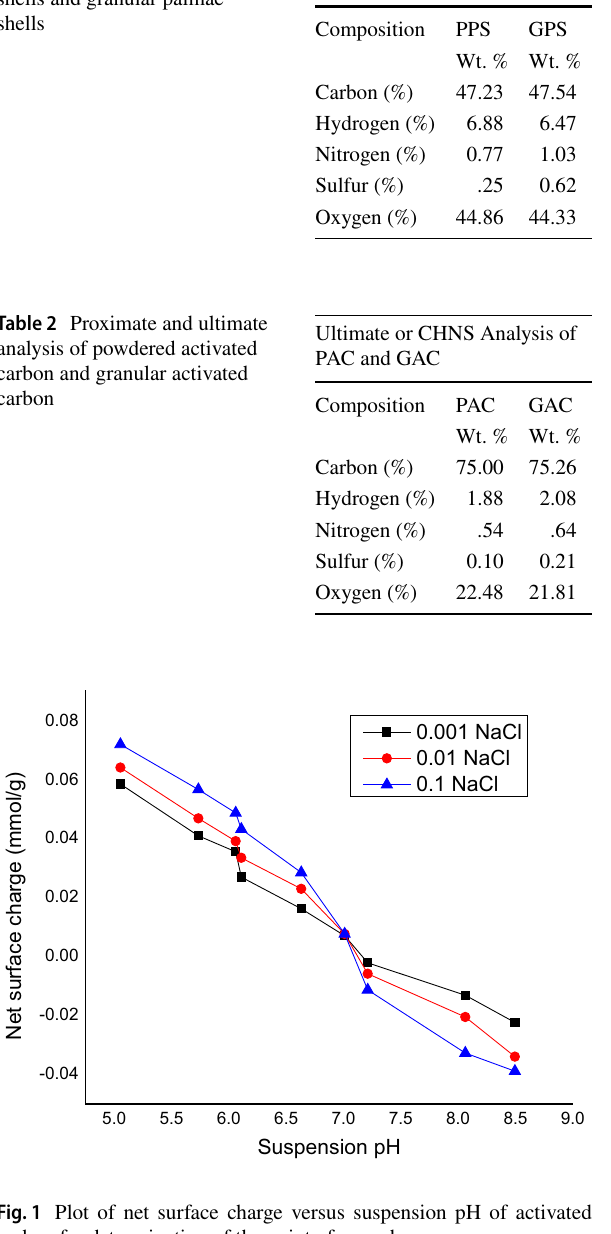
Fig. 1 Plot of net surface charge versus suspension pH of activated carbon for determination of the point of zero